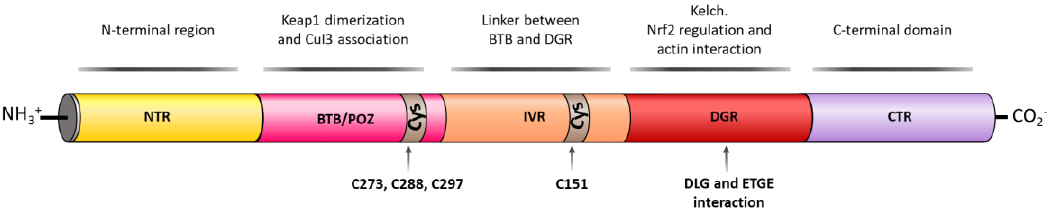
Figure 6. KEAP1 structural domains and their related activity. KEAP1 contains an N-terminal region (NTR), a Tramtrack and Bric- á -Brac (BTB) domain that enables KEAP1 homodimerization and responsible for Cul3 E3 ligase binding. The BTB domain also contains three important Cys residues (Cys 273 , Cys 288 , and Cys 297 ) able to react with free radicals and / or electrophiles inducing a conformational change in KEAP1 that liberates NRF2 in the cytosol. The next domain is an intervening region (IVR) that also contains an important Cys residue, Cys 151 , which is able to react with free radicals and or electrophiles and an NES motif that regulates the cytoplasmatic location of KEAP1. The double glycine repeat (DGR) domain contains six kelch repeats that contain the binding sites of NRF2, p62, and related E / STGE proteins. Finally, KEAP1 contains the C-terminal domain (CTR).